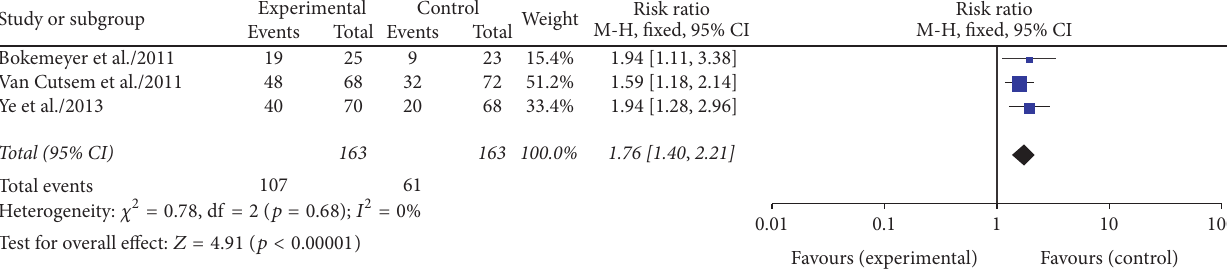
CIStudy or subgroup